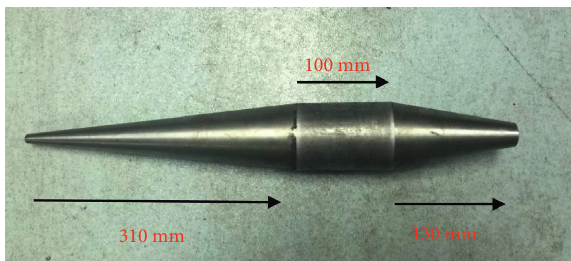
Figure 2: Biconical impact rod of cone.